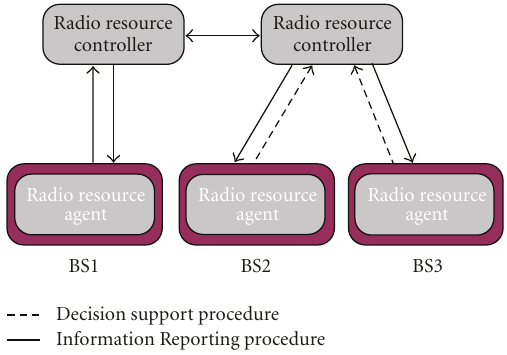
Figure 4: Radio resource allocation